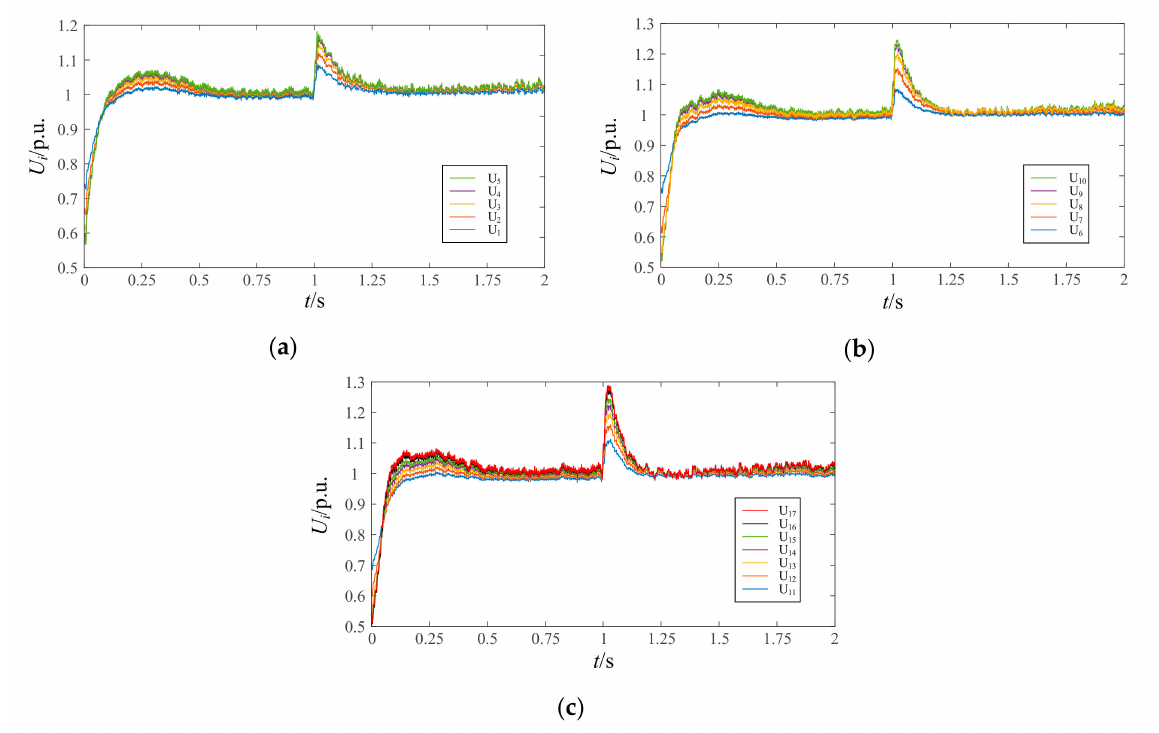
Figure 14. The generator terminal voltage variation curves, when taking the grid-connection node as the control target.